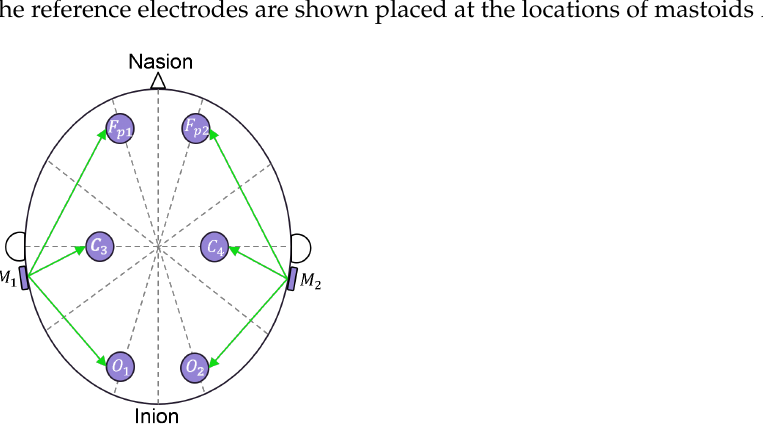
Figure 1. Placement of the EEG electrodes according to the 10/20